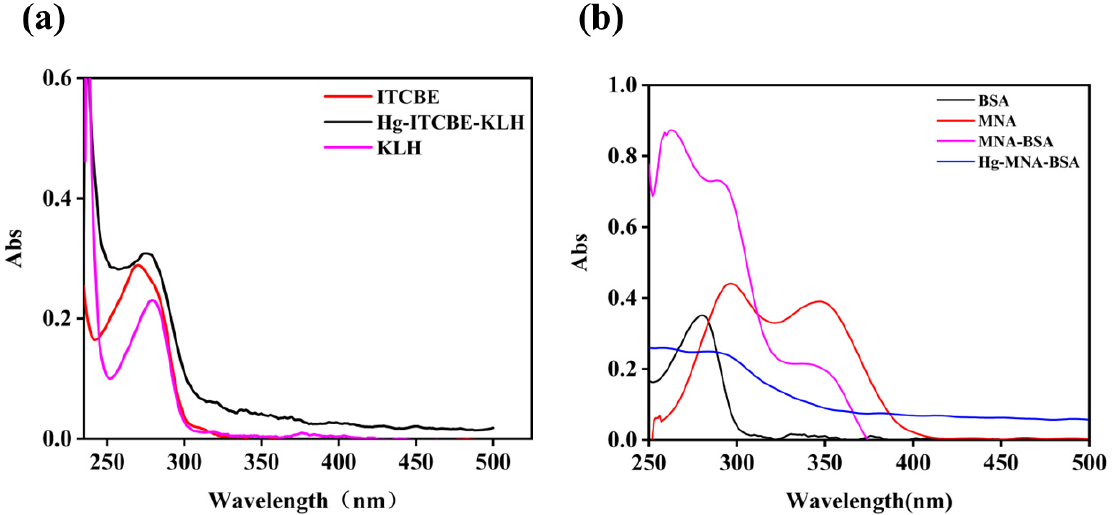
Figure 3. The UV–Vis spectroscopy of antigen. ( a ) Confirmation of immunogen (Hg–ITCBE–KLH). ( b ) Confirmation of coating antigen (Hg–MNA-BSA).